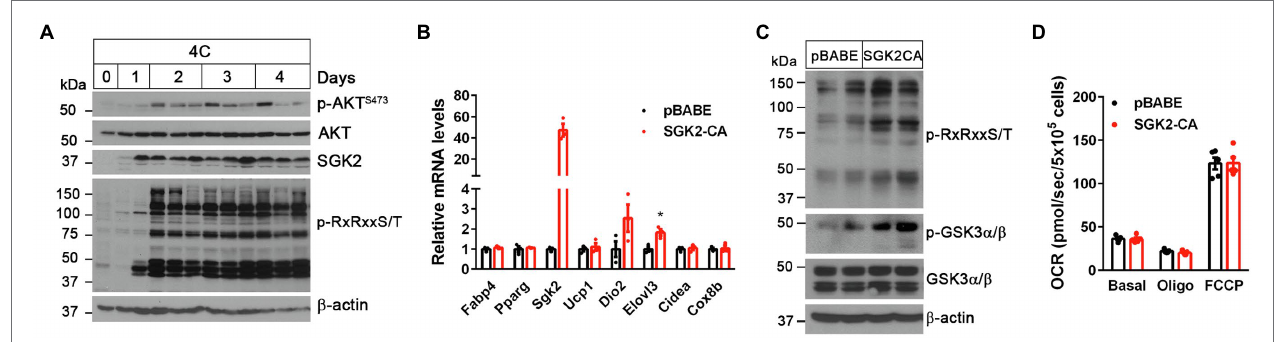
FIGURE 2 | SGK2 activation induces phosphorylation of downstream substrates in brown adipocytes. (A) Cold-dependent activation of SGK2 signaling in BAT. 9-week old BL6 mice were exposed to 4 ° C for indicated times. (B) No change in expression of genes involved in brown adipogenesis and thermogenesis by SGK2 activation. Brown preadipocytes were transduced with retrovirus expressing an empty vector or SGK2-S356D, followed by differentiation into brown adipocytes for 7 days ( n = 3 per group). (C) Effect of SGK2 activation on downstream signaling in brown adipocytes starved for serum for 8 h. (D) Effect of SGK2 activation on mitochondrial respiration in brown adipocytes. Oxygen consumption rates (OCR) were measured in differentiated brown adipocytes (7 days) at baseline and after addition of oligomycin and FCCP ( n = 5 per group). All data are presented as the mean ± SEM. * p < 0.05 determined by Student’s t